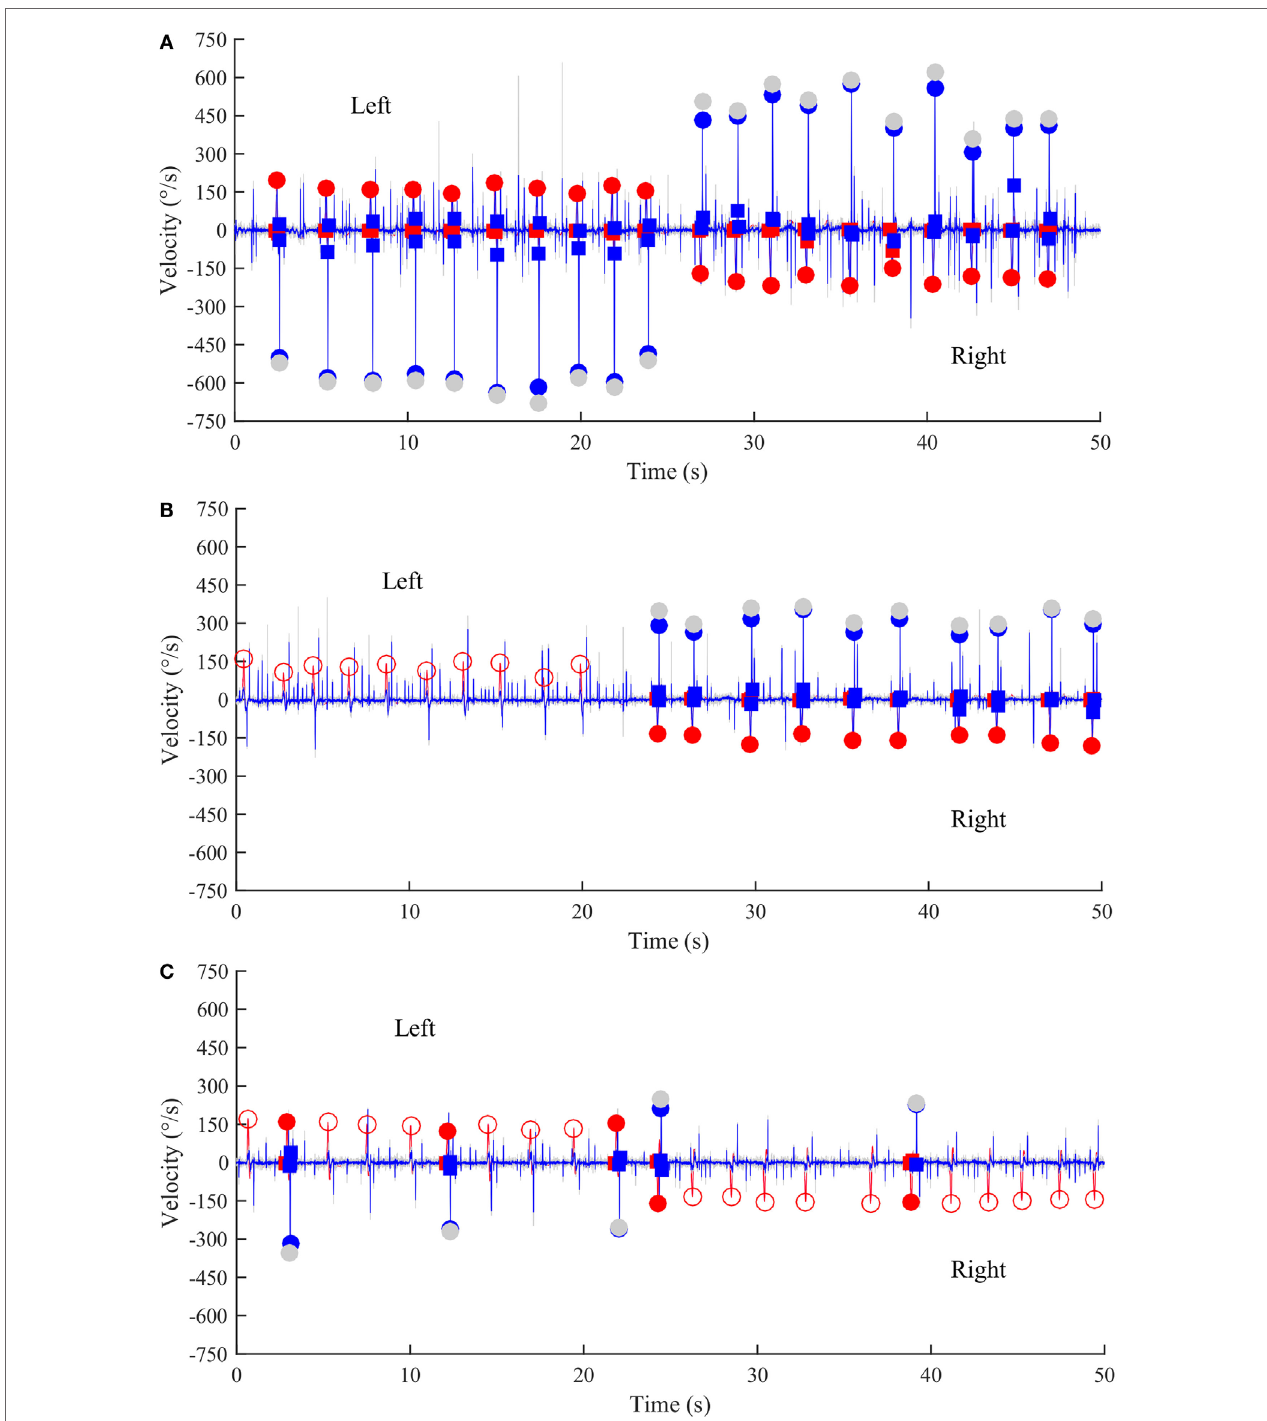
FigUre 3 | Time series of anti-compensatory saccades in a normal subject, a left UVl patient, and a BVl patient . (a) Anti-compensatory saccades were detected when head impulses were directed either to the left (up, 2–24 s) or to the right side (down, from 27–47 s) in a normal subject. (B) No anti-compensatory saccades were detected when head impulses were directed toward the lesioned left side (up, 0–20 s) in a patient operated from a left vestibular schwannoma and tested in acute stage. In contrast, anti-compensatory saccades could be detected for head impulses toward the intact right side (down, 24–50 s). (c) Few anti-compensatory saccades were detected when head impulses were directed either toward the left (up, 0–22 s) or toward the right side (down, 24–50 s) in a BVL patient. Red curve: head velocity; blue curve: eye velocity; blue circles: peak saccade velocity; red circles: peak head velocity; empty red circles: head impulses in which anti-compensatory saccades were not followed after the head turn; gray circles: non-filtered peak saccade velocity.